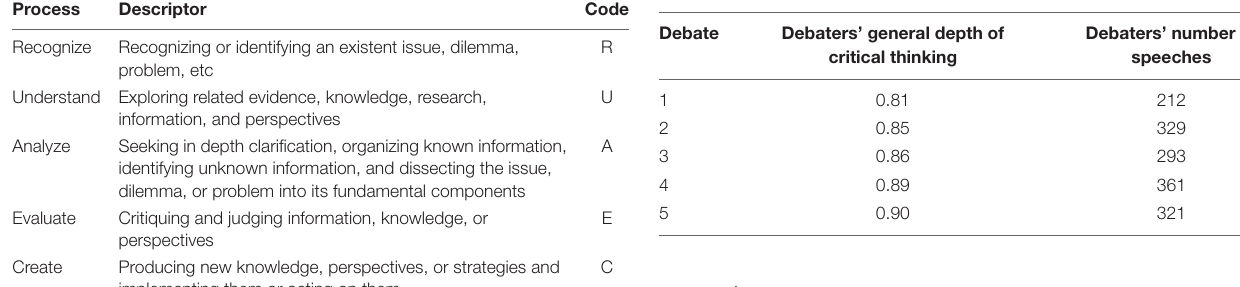
TABLE 5 | Correlation analysis of debaters’ depth of critical thinking and number of